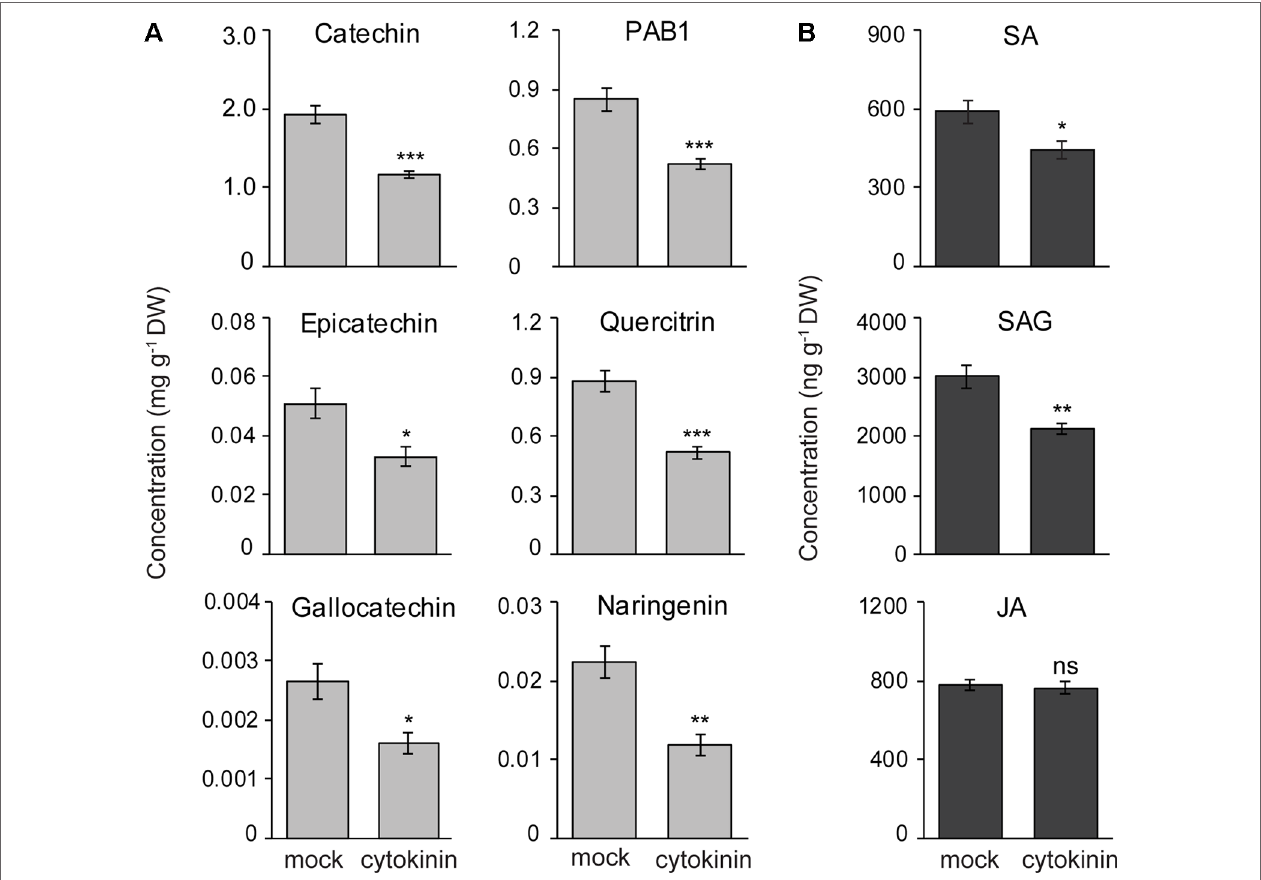
FIgURe 7 | Exogenous cytokinin treatment of P. nigra resulted in lower accumulation of flavan-3-ol metabolites in stems. Poplar trees were treated with zeatin (2.5 µM). Stem samples were harvested from separate trees 7 days after spraying. The concentrations of (A) flavan-3-ols and some other flavonoids, and (B) phytohormones were monitored in poplar stems. Data were analyzed using Student’s t-test (*, p ≤ 0.05; **, p < 0.01; and ***, p < 0.001; ns, non-significant). Data presented in figures are mean ± SE (n = 8). PAB1, procyanidin B1; SA, salicylic acid, SAG, SA-glucoside; JA, jasmonic acid; DW, dry weight.